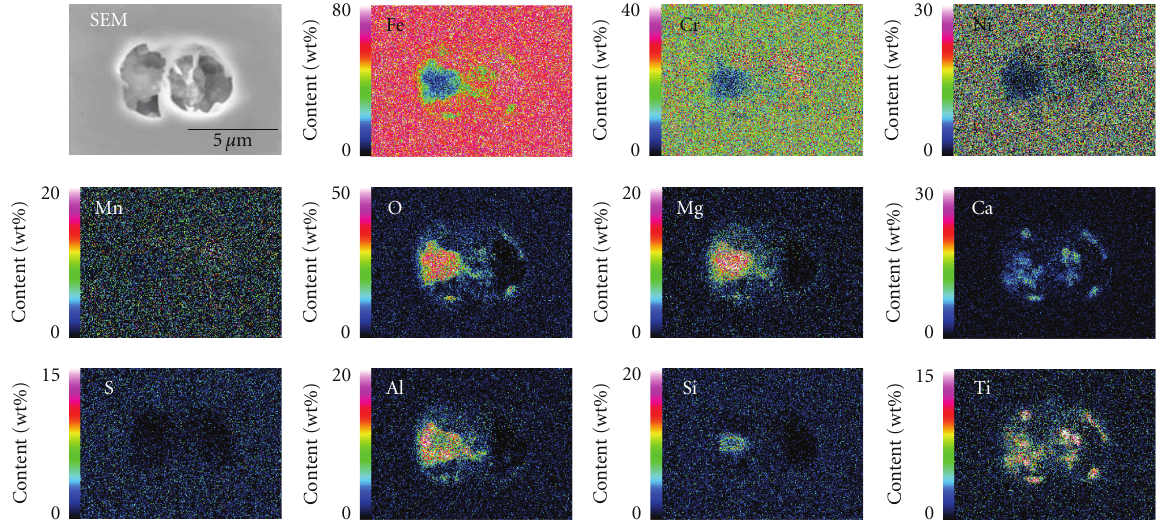
Figure 3: SEM image and EDS elemental mappings for the same region as in Figure 2 after polarization treatment at 0.5V for 30 min in 1M Na 2 SO 4 of pH